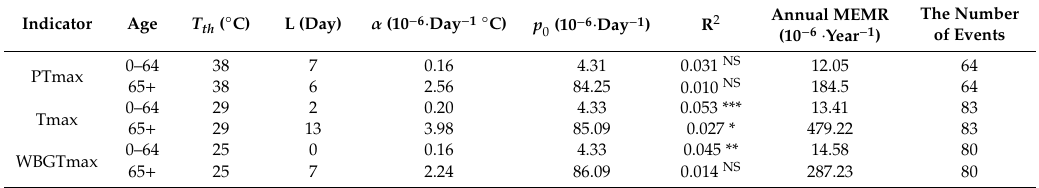
Table 3. Estimated free parameters, coefficient of determination, and annual mean excess mortality rate (MEMR) for the fitted heat-related risk assessment model depending on the age for the training period (2000–2016).